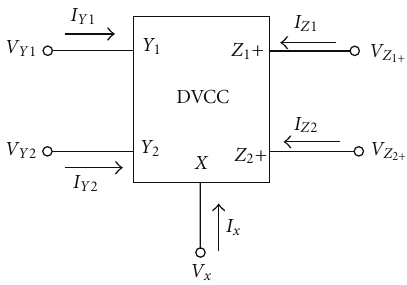
Figure 1: Symbol of DVCC with two Z + stages.